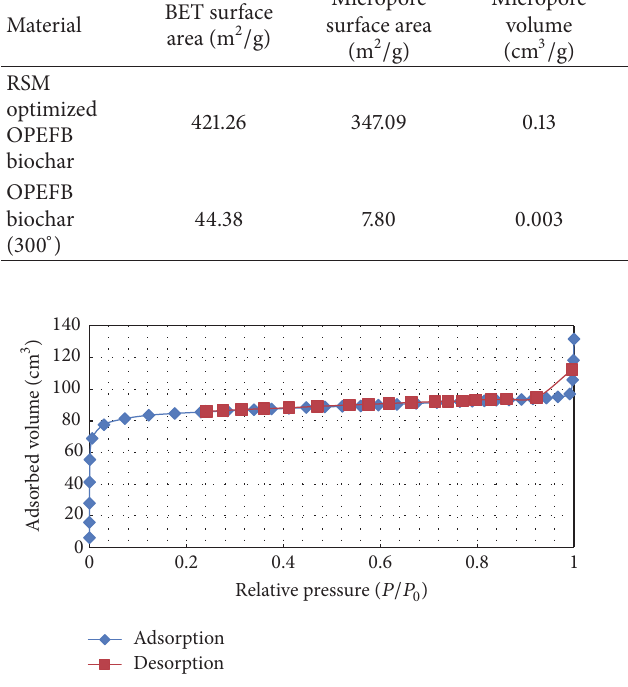
Figure6:Adsorption-desorptionisothermgraphofOPEFBbiochar produced at RSM optimum